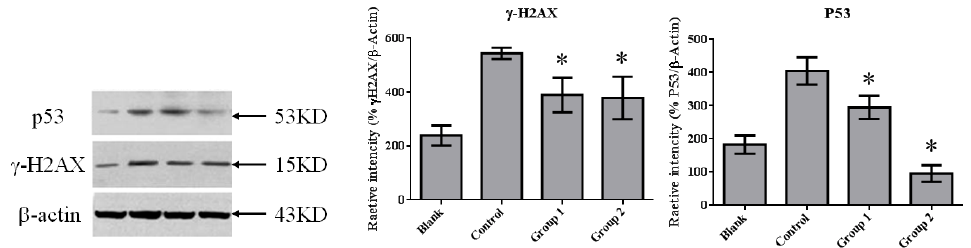
Figure 8. The expression of γ -H2AX and P53 in colorectal tissue. γ -H2AX expression was significantly inhibited by ASR extract treatment (Groups 1 and 2). The amount of sample in each group was n = 8 (blank group), n = 6 (control group), n = 7 (Group 1), n = 7 (Group 2). p > 0.05 and * p < 0.05 when compared with the control group.